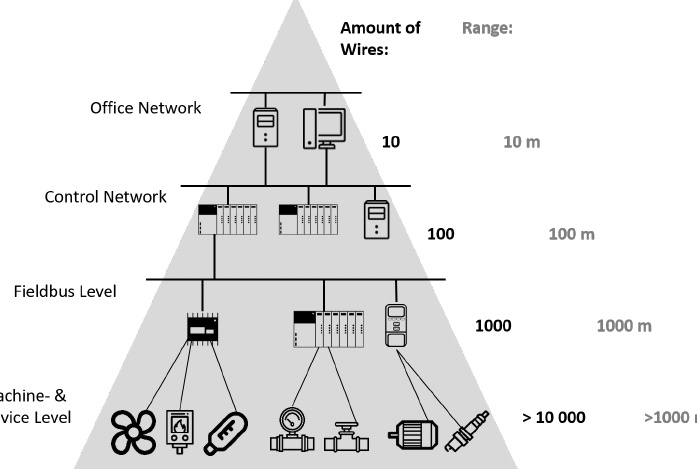
Figure 1. Node density exponentially increases from the top (office network/Internet/Intranet) to the bottom (machine- and device-level) in a typical automation system network